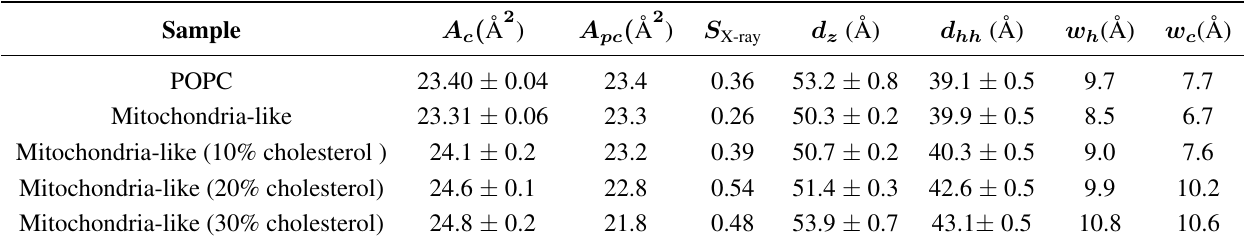
Table 1. Structural properties measured for the samples used in this